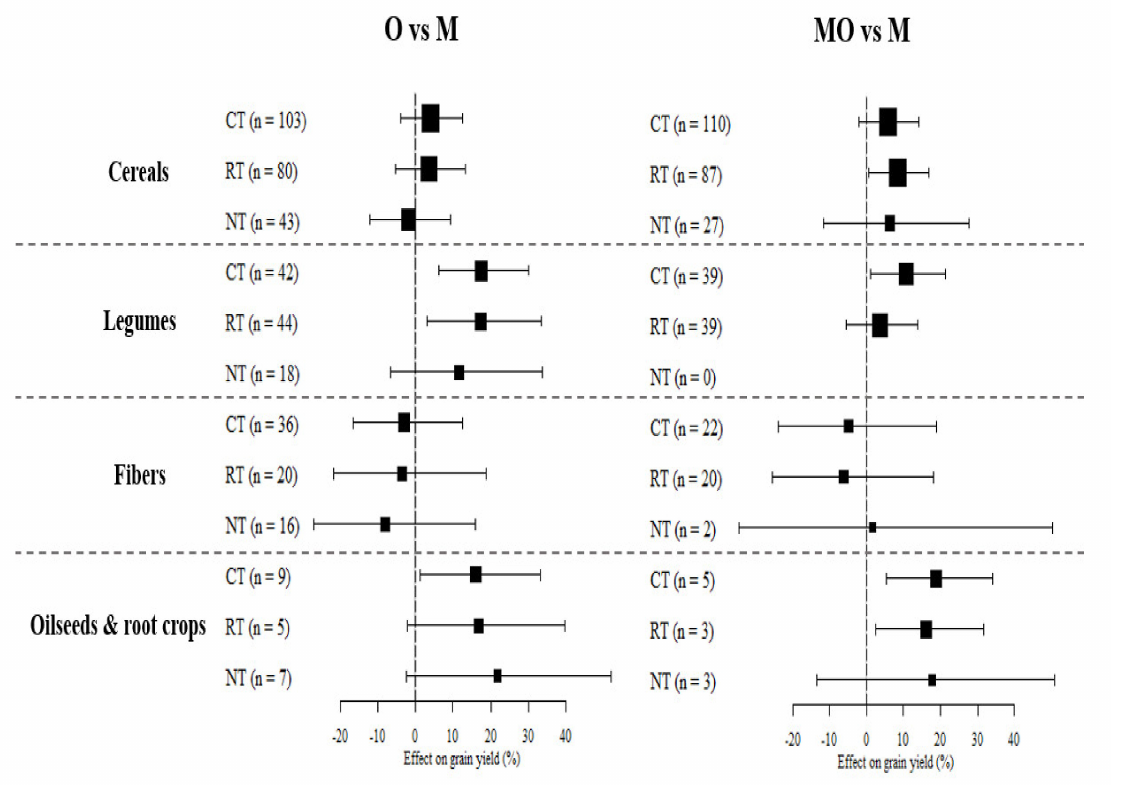
Figure 6. The crop yield response of organic vs. mineral (O vs. M), and mineral + organic vs. mineral (MO vs. M) under conventional, reduced and no-tillage practices (CT, RT, and NT, respectively) in different crop categories, expressed as the average effect on crop yield (%). “n” refers to the number of observations for each subgroup. The vertical line represents the null hypothesis [ ln ( RR ) = 0]. The squares are the point estimate of effect size. The horizontal lines are the associated 95% confidence interval for the population